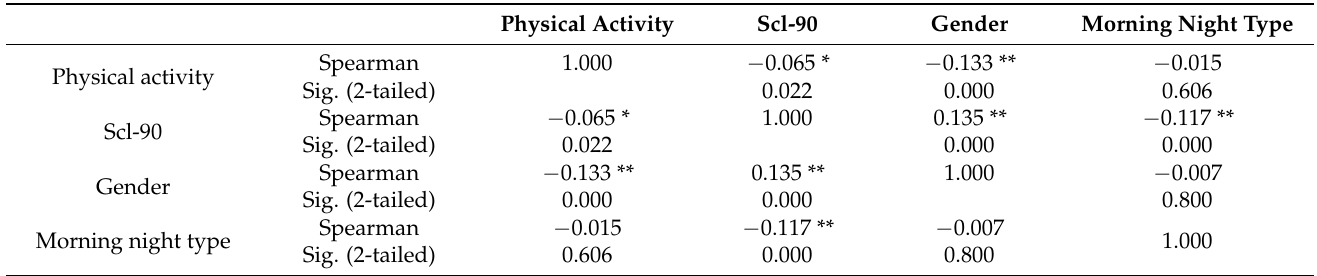
Table 1. Correlation between gender, physical activity, circadian rhythm differences, and SCL-90 in the total population N = 1241.